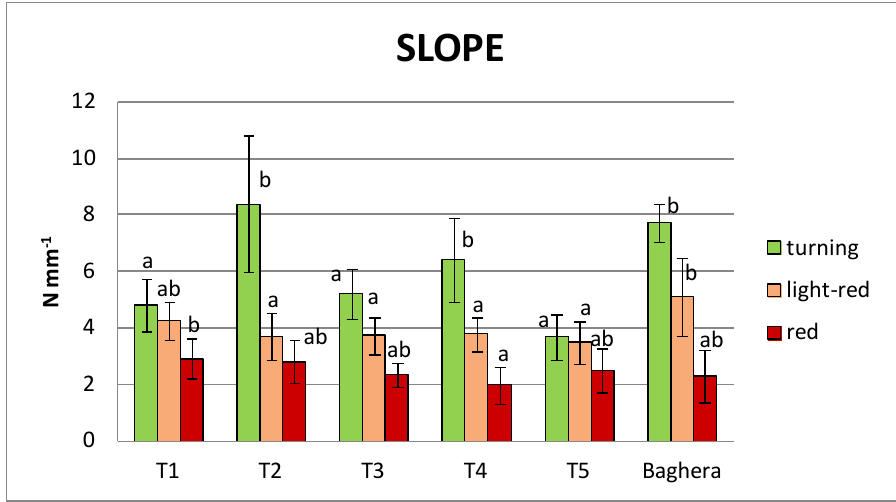
Figure 3. Tomato firmness. For each ripening stage, different letters represent significant differences according to Tukey’s test ( p < 0.05). Mean values and standard deviation.